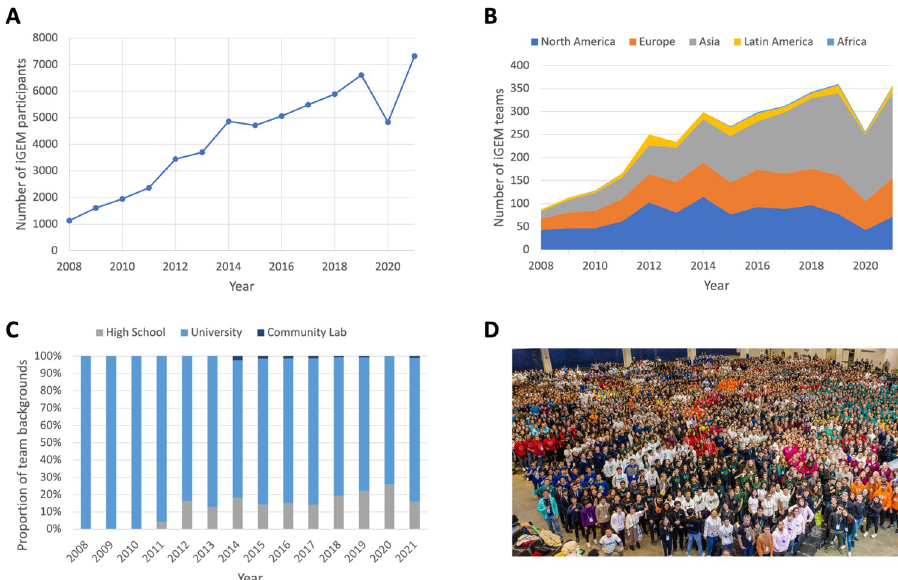
Fig 1. iGEM participation has increased around the world in the last decade. (A) Total number of recorded participants in iGEM competitions. (B) A breakdown of team locations for each competition. We see here a large increase in teams from the Asian region (as defined by iGEM) since 2014. In both instances, we see that the competition has recovered in 2021 after a COVID-disrupted 2020. (C) The background of teams shows an increase in high school entrants as a proportion of total entrants in the last decade. All data are publicly available from the iGEM Foundation. (D) Photo of the participants from the 2019 iGEM competition (photo from the iGEM Foundation). iGEM, international Genetically Engineered